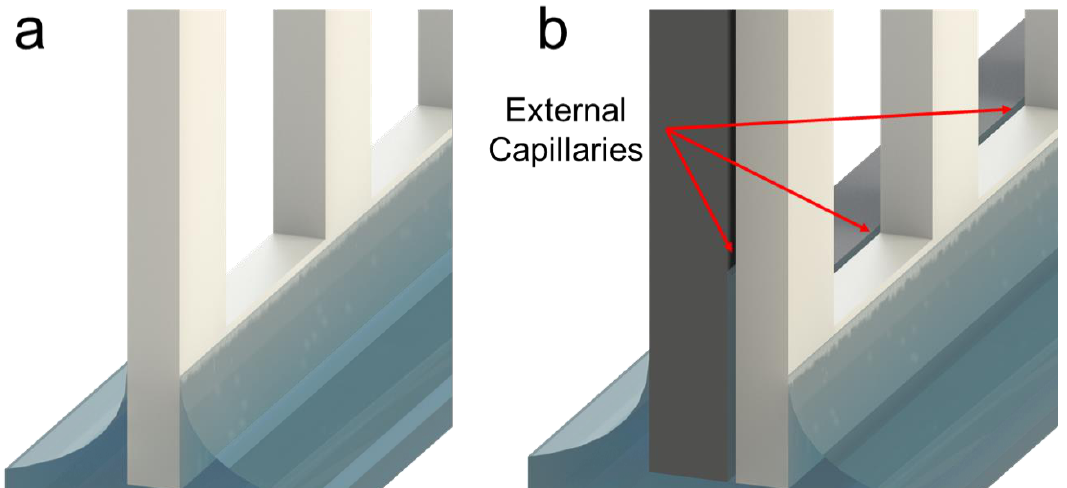
Figure A5. XPS Carbon 1s spectra of laser-etched Whatman #1 chromatography paper. Unetched paper (0%) was compared to paper etched at the highest grayscale value (100%). The washed paper was simply dipped into DI H 2 O and allowed to dry at room temperature.